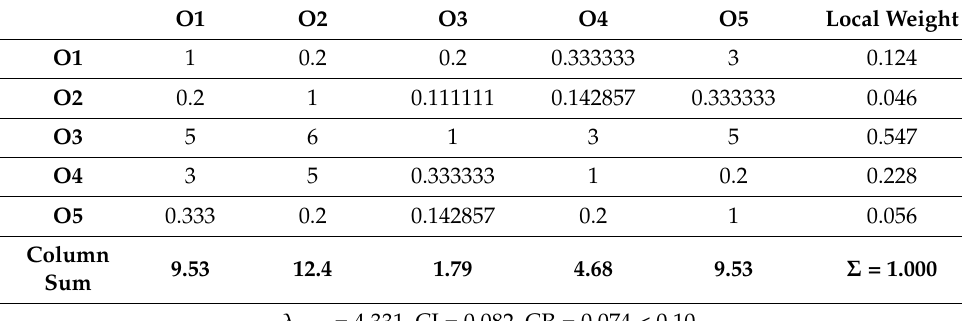
Table 12. Pairwise comparison for “Opportunities” category.